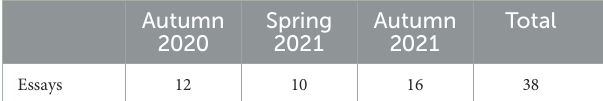
TABLE 2 Summary of collected